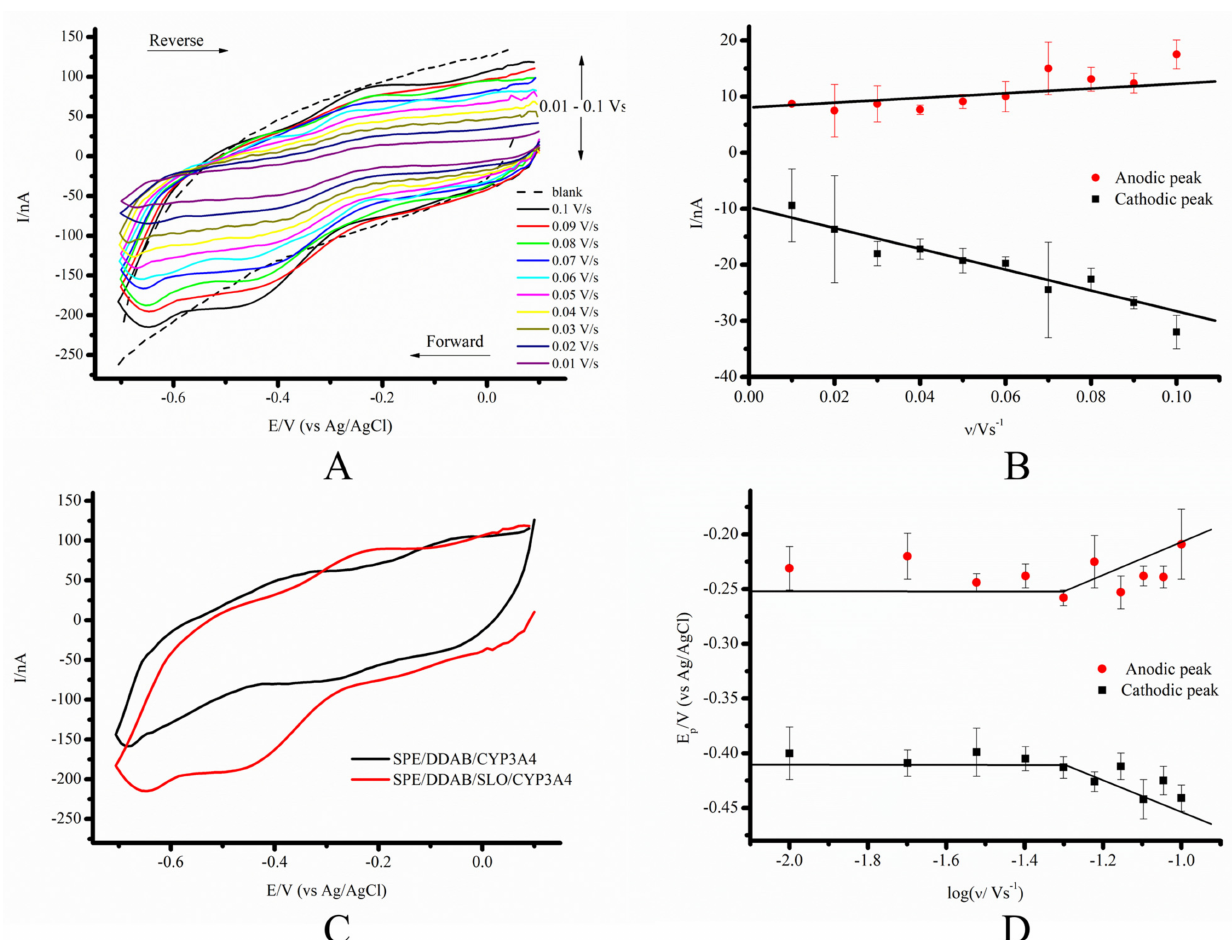
Figure 2. ( A ) CVs of SPE/DDAB/SLO/CYP3A4 in anaerobic conditions. ( B ) Scan rate depen- dence of the cathodic and anodic peak currents on the potential for SPE/DDAB/SLO/CYP3A4. ( C ) CVs of SPE/DDAB/CYP3A4 and SPE/DDAB/SLO/CYP3A4 at scan rate of 0.1 V/s. ( D ) Trumpet plots displaying the oxidation and reduction peak potentials with logarithm scan rate for SPE/DDAB/SLO/CYP3A4. Measurement parameters: potential sweep rate from 0.01 to 0.1 V/s, potential range from − 0.7 to 0.1 V (vs. Ag/AgCl). The measurements were carried out in 1 mL of supporting electrolyte 0.1 M potassium phosphate buffer (pH 7.4) containing 0.05 M